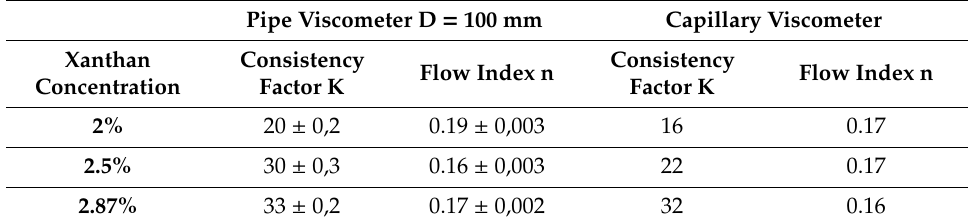
Table 4. Validation runs for the pipe viscometer (results for diameter 100 mm in triplicate).